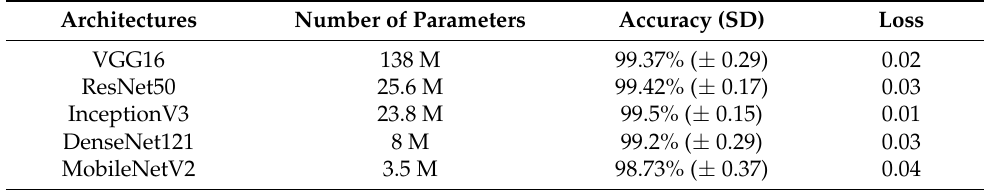
Table 2. Comparison of different deep learning architectures.